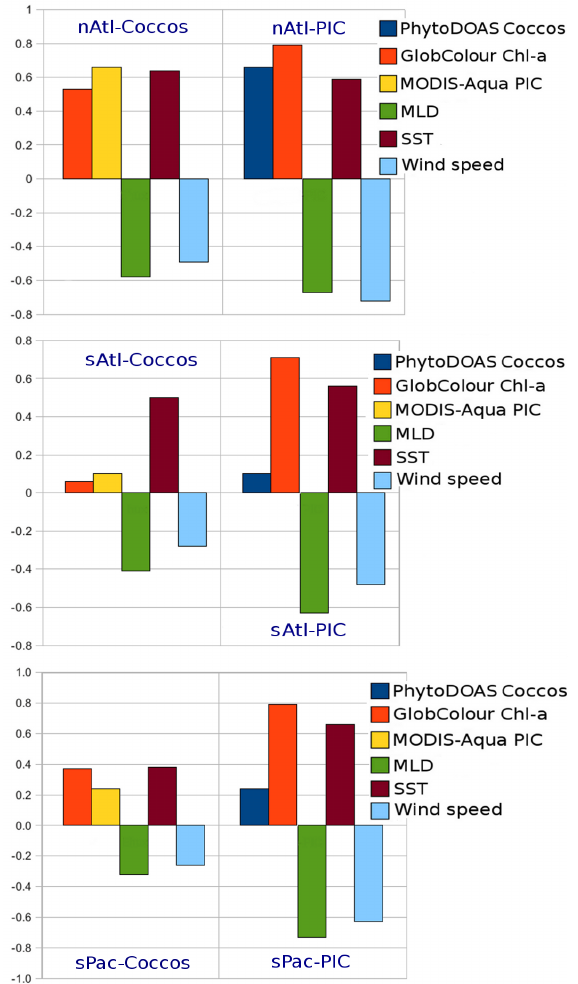
Fig. 8. Correlation coefficients between time series of PhytoDOAS coccolithophore chl-a (left partitions) and the other parameters in three investigated regions: nAtl (upper panel), sAtl (middle panel) and sPac (lower panel). Correlation coefficients between time series of PIC and the other parameters are depicted on the right partitions of the panels, respective to the three regions.